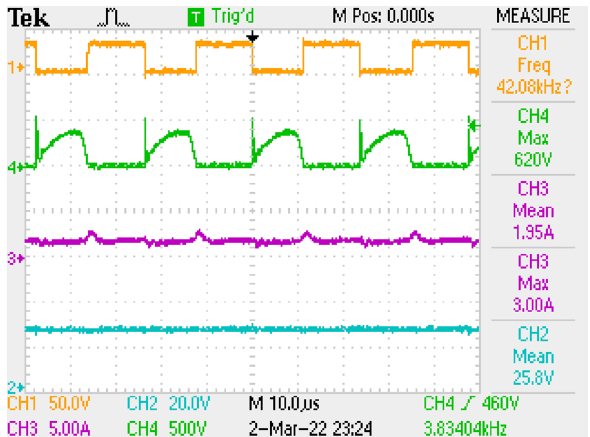
Figure 28. By LCL with C DM filter, (zoomed of Fig. 27).